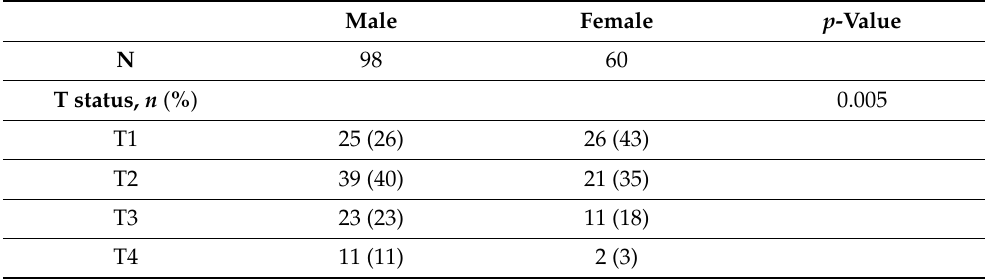
patients (Table 3). Table 3. T status distribution among men and women in reconstructed patients ( n =